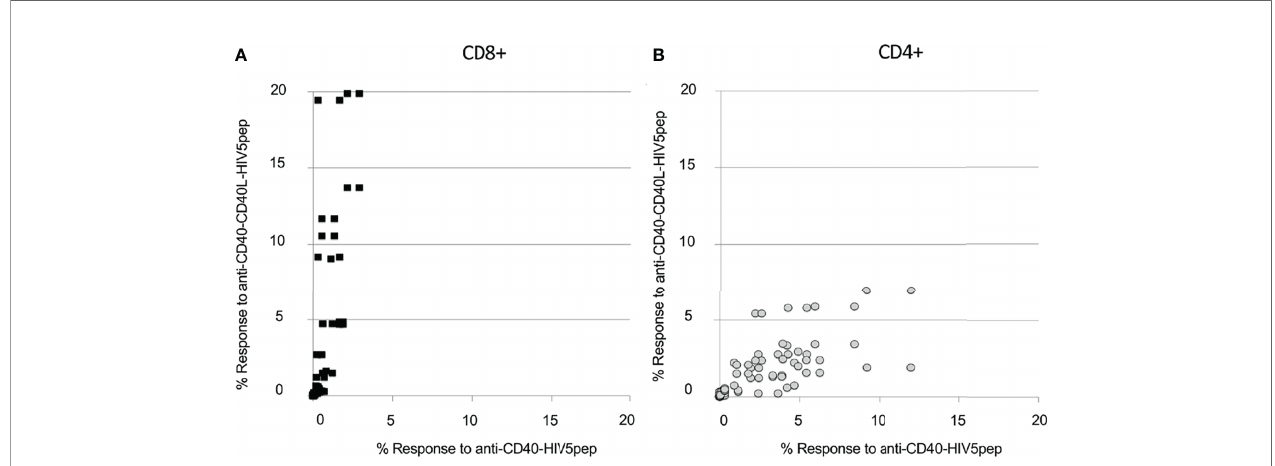
FIGURE 6 | Anti-CD40-CD40L targeted HIV5pep antigens preferentially expand many HIV-1-speci fi c CD8 + T cell responses in HIV-1-infected donor PBMC cultures. HIV-1 + donor PBMCs were cultured for 9 days with IL-2 and anti-CD40 HIV5pep fusion proteins (1 nM; 2 nM for KIH proteins), followed by stimulation with long peptides speci fi c for each of the fi ve HIV-1 Gag, Nef, and Pol regions for 6 h with BFA, then analyzed by ICS. This is collated data from experiments with each of the indicated protein pairs tested on four donors. Each point represents the % value for IFN g + + TNF a + HIV5pep-speci fi c CD8 + [panel (A) , black fi lled squares] or CD4 + [ (B) , gray circles] T cells for each response speci fi c to each long peptide elicited in each donor comparing anti-CD40 11B6-CD40L-HIV5pep KIH Gen 2 and anti- CD40 11B6-CD40L-HIV5pep Gen 1 (Y axis) to anti-CD40 12E12-HIV5pep KIH Gen 2 and anti-CD40 12E12-HIV5pep Gen 2 (X axis). The fold difference between the antigen-speci fi c CD8 + T cell responses elicited by anti-CD40 11B6-CD40L versus anti-CD40 12E12 was on average 7.2X, with a minimum of 0.3X and a maximum of 61X, calculated on 36 coupled values in which 30 had a greater response to anti-CD40 11B6-CD40L. For this calculation, the threshold was 0.5% response in at least one of the coupled values. (B) Shows the whole dataset. The fold difference between the antigen-speci fi c CD4 + T cell responses elicited by anti-CD40 11B6- CD40L versus anti-CD40 12E12 was on average 0.7X, with a minimum of 0.15X and a maximum of 2.4X, calculated on 44 coupled values in which 34 had a greater response to anti-CD40 12E12. For this calculation, the threshold was 0.5% in the response in both of the values in the